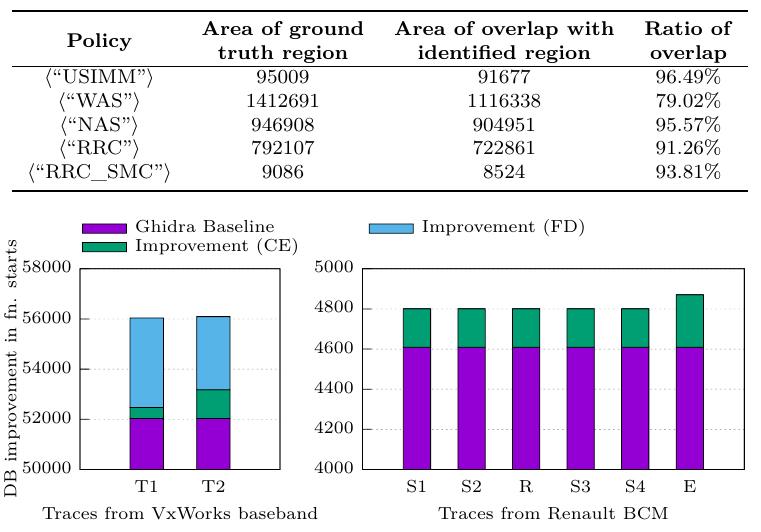
Table 2: Comparison of size and ratio of overlap of manually identified regions compared to regions identified by Incision for policies used in Section 5.3.2.